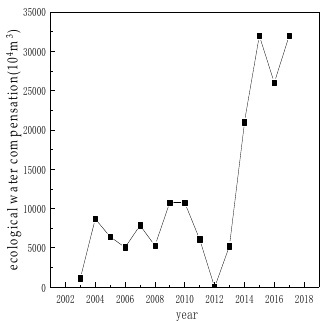
Figure 14. The ecological water compensation in Ulansuhai from 2003 to